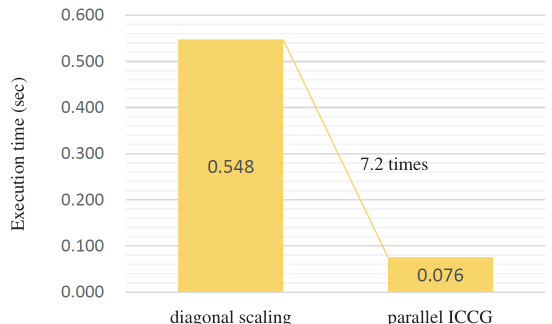
Figure 8. Execution time for the 101 × 101 mesh.